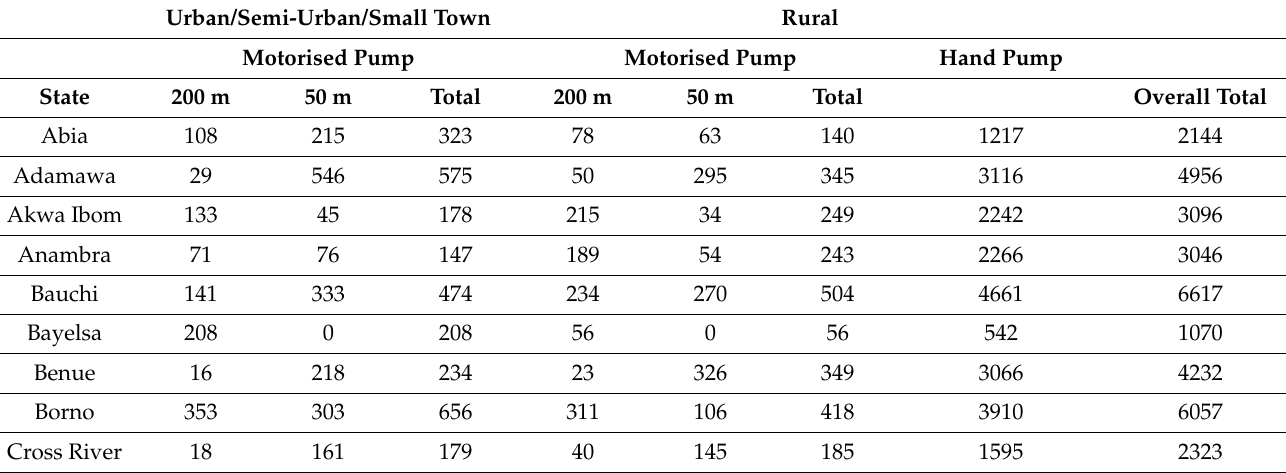
Table A5. Number of newly drilled borehole to meet water demand of 2030. Source: [37]. Urban/Semi-Urban/Small Town Rural Motorised Pump Motorised